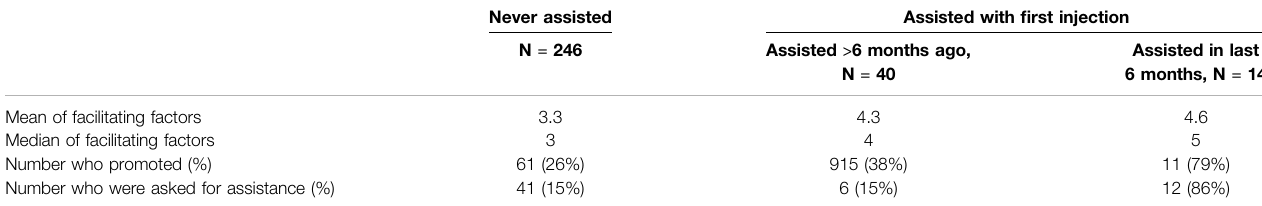
TABLE 5 | Comparison of promoting behaviors and being asked to help among those who had never helped someone inject, those who had helped prior to previous 6 months, and those who in the last 6 months among PWID in